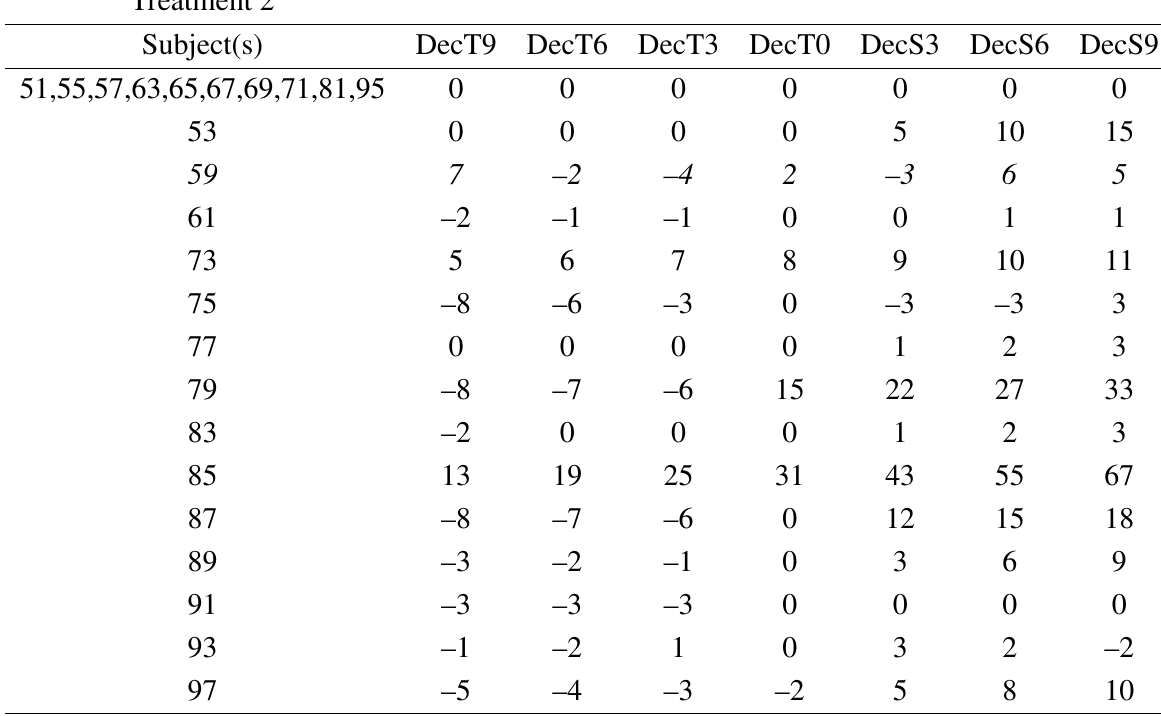
Table 3 . Player 2 behavior in the Moonlighting-game with unequal endowments (Treatment 2). DecT x and DecS y are the decisions of Player 2 after Player 1 has taken x EMU or sent y EMU, respectively, where sending y implies gains of 3 y for Player 2. A positive value indicates the number of EMU sent back, a negative value the number of reduction points assigned, where each reduction point costs 3 EMU to player 1. Subject 59 is apparently